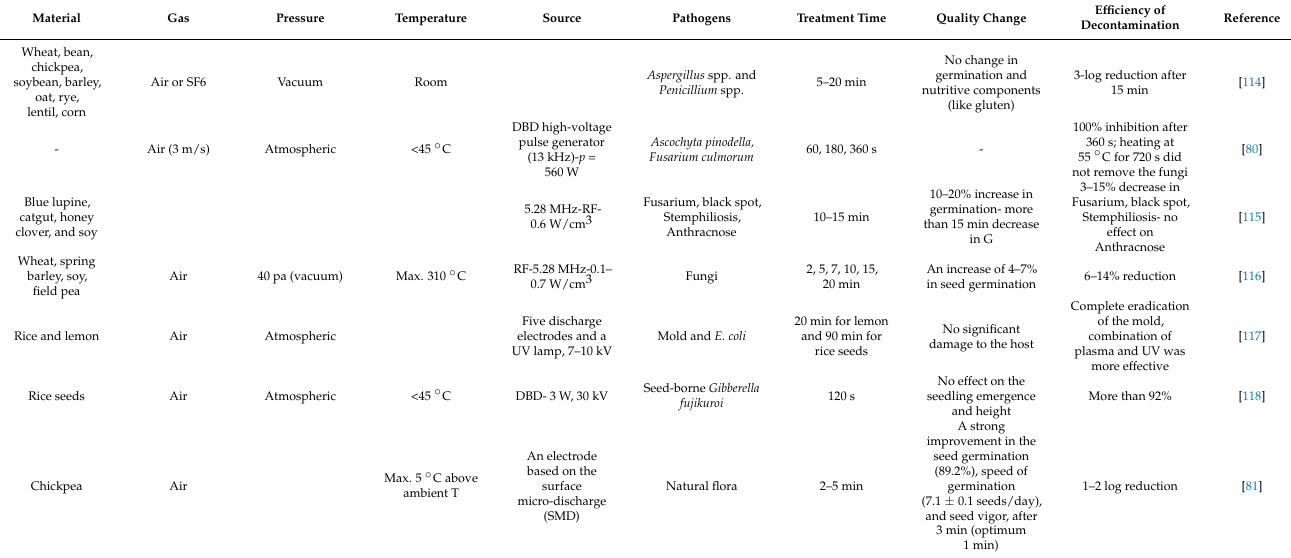
Table 3. Treatment of grains using cold plasma with the aim of